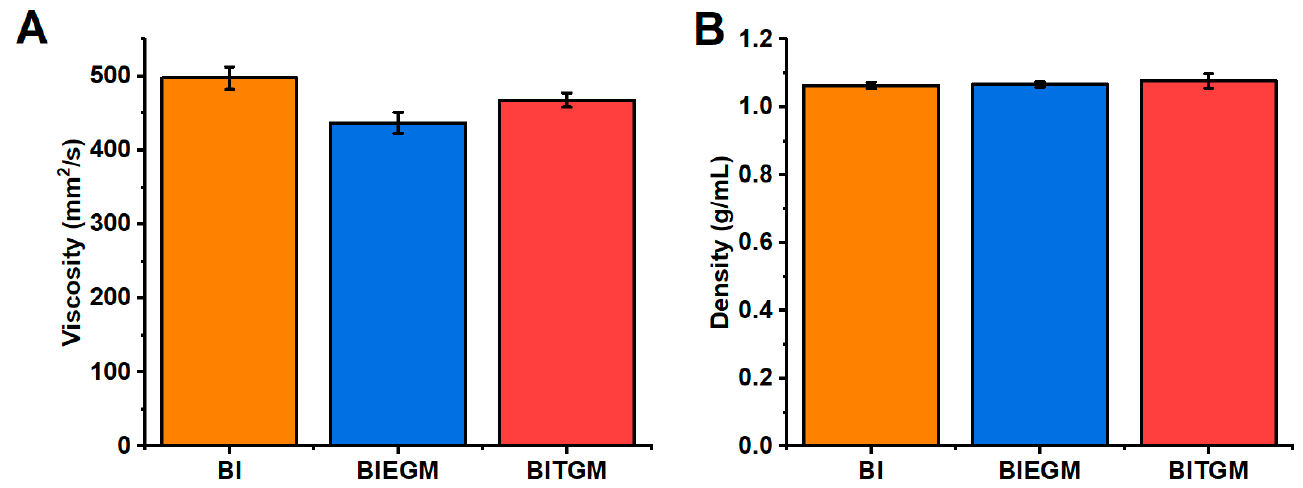
Figure 7. ( A ) Kinematic viscosities and ( B ) densities of BI, BIEGM, and BITGM. Microsphere ‐ incorporation did not negatively affect the scaffolding process. Micro ‐ spheres were intact and no physical deformities were observed. Both EGM and TGM dis ‐ tributed evenly in within their scaffold withing aggregation and deformation (Figure 8).